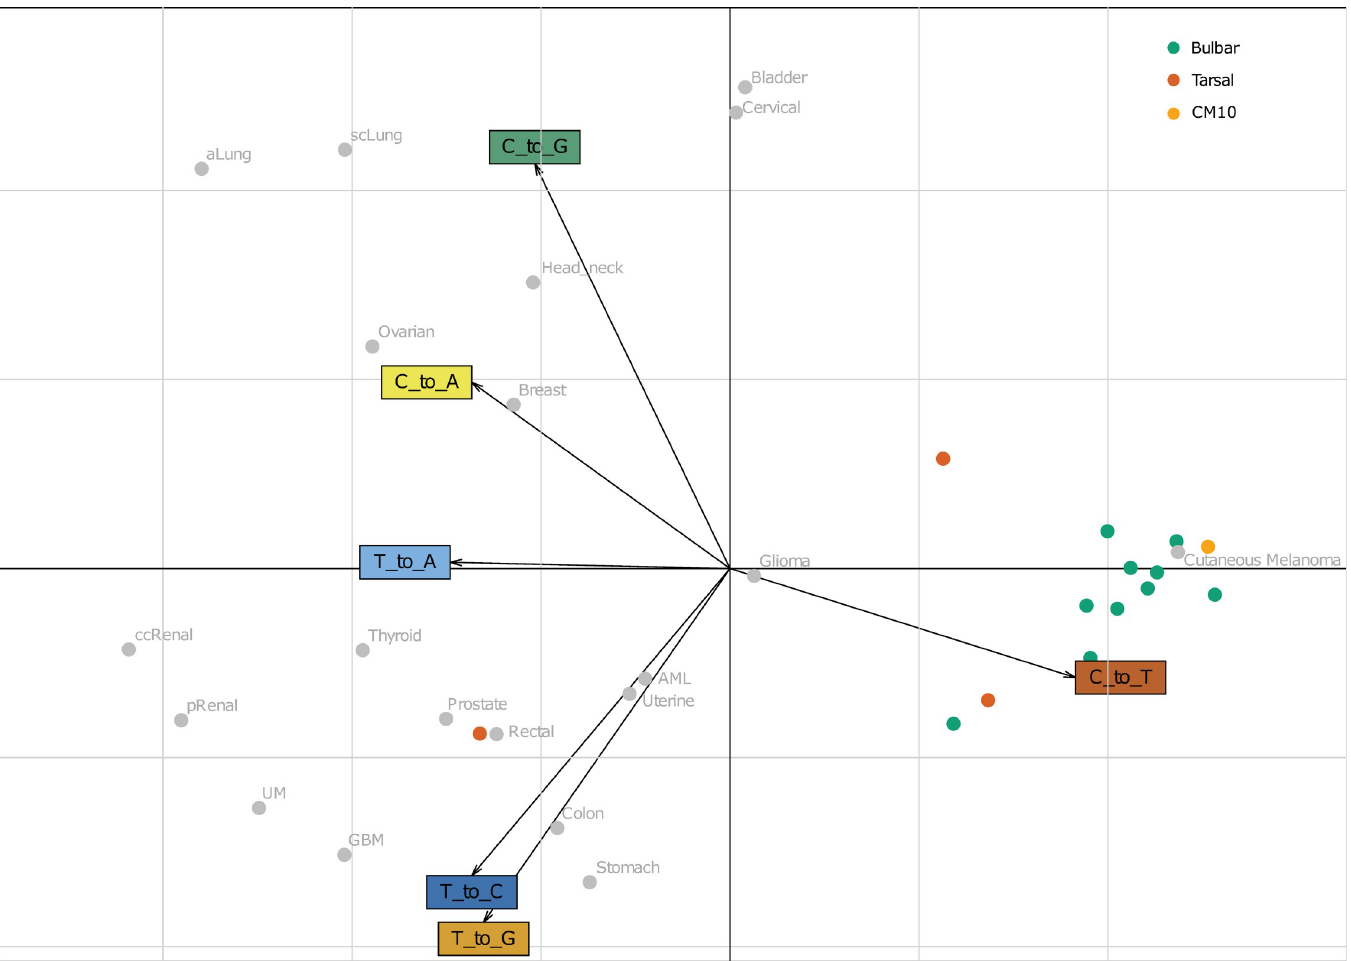
Fig 2. Principal-component analysis (PCA) of the mutational spectrum data. PCA is showing the similarity between CJM and CM, as well as a possible separation of tarsal vs. bulbar CJM tumors.